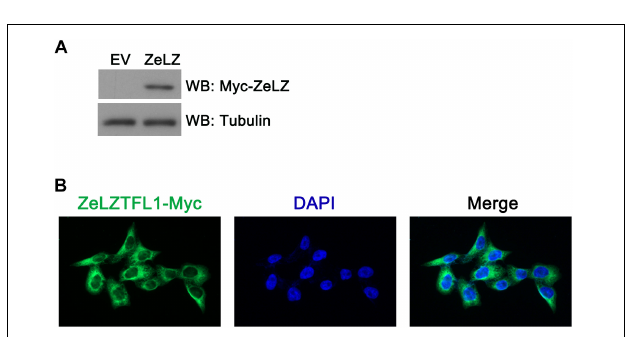
FIGURE 4 | Unrooted phylogenetic tree of LZTFL1 protein was constructed using the neighbor-joining method by Mega 6.0. Node values represent the percent bootstrap confidence derived from 1000 replicates.